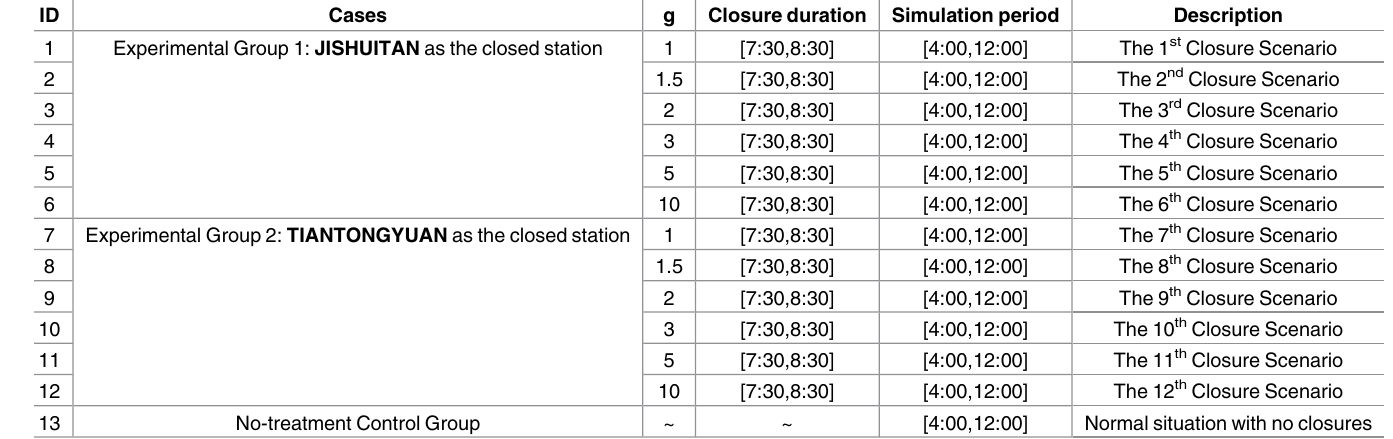
Effects of a station closure on passenger behavioral choices. (1) Passengers’ behavior choices will change as the closure duration or its overestimation changes . Fig 16 shows that with increasing closure duration, more passengers will alter their planned origin stations or quit their rail transit journey, and fewer passengers will wait at the closed station for its recov- ery. A similar conclusion can be drawn when g increases, as shown in Fig 17. With increasing g , which means that the rail transit operator’s overestimation of the closure duration increases, the number of passengers who alter their planned origin stations or give up on their rail transit journey gradually increases, and the number of passengers waiting at the closed station decreases. Table 3. The different values of the parameters in the simulation